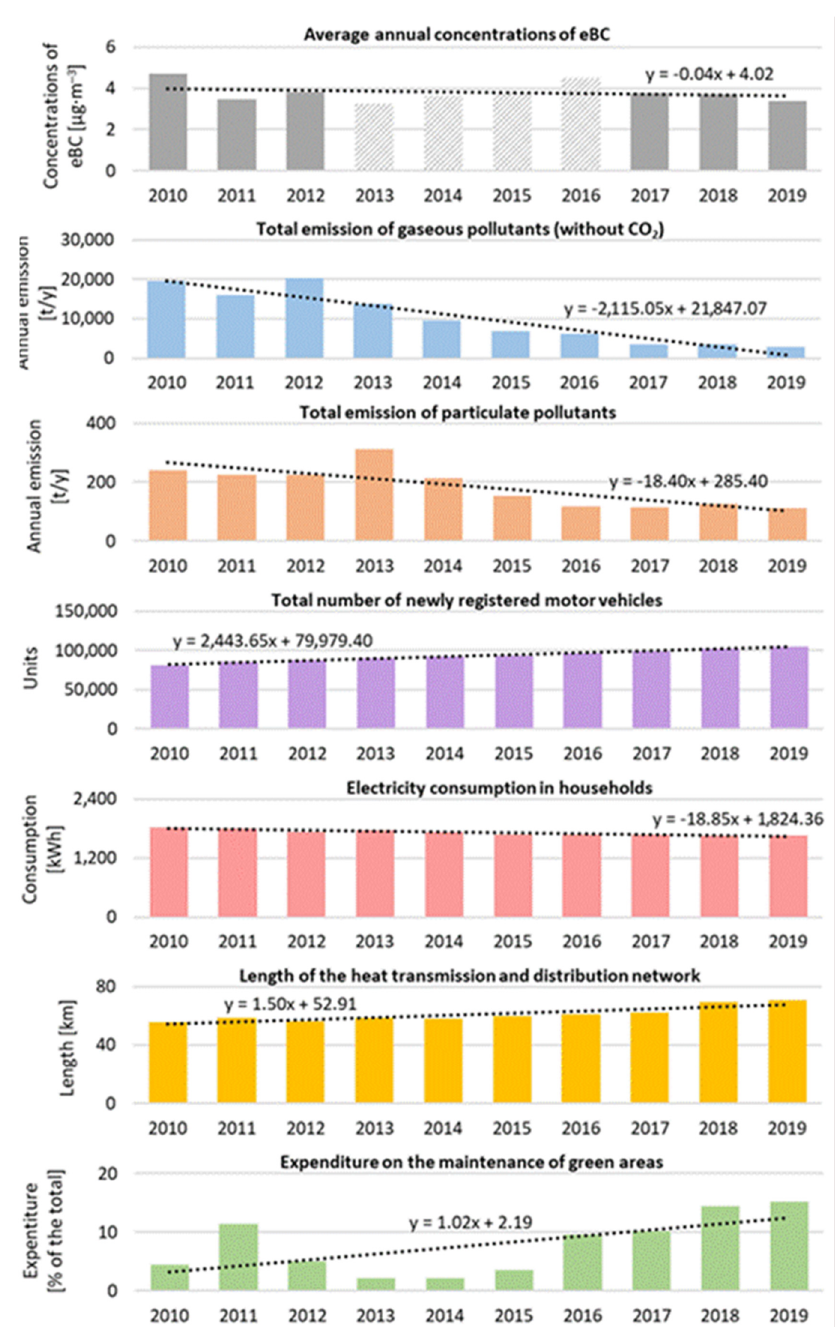
Figure 8. Average annual concentrations of eBC in Zabrze from 2010–2019, compared to the values of selected parameters collected in the Central Statistical Office database. The trend line is marked with a black dotted line. An incomplete filling in the eBC chart means that the required time coverage has not been achieved in a given